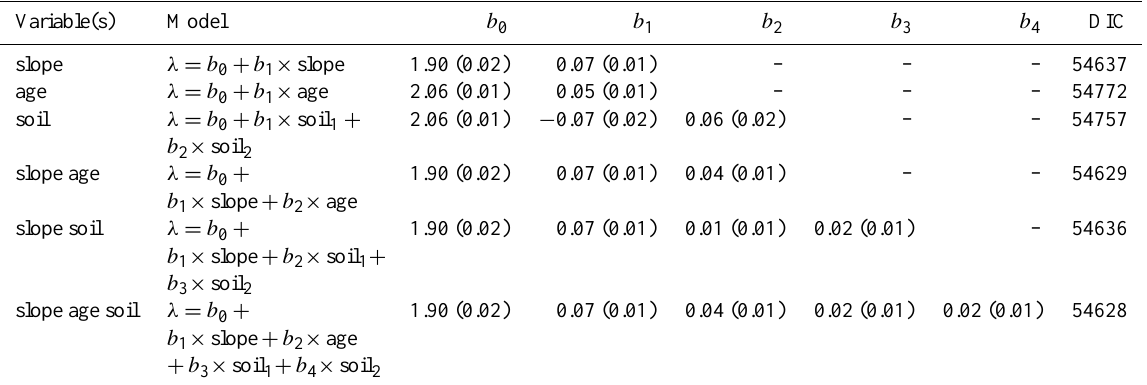
Fig. 3. Differences in the frequency distribution of canopy height between (a) the primary and old-growth forest, and (b) among the three soil types. Table 3. Hierarchical Bayesian model for the effect of slope, forest age and soil type on the gap size distribution ( λ) showing means (and standard errors) of each parameter calculated using MCMC and the model deviance information criterion (DIC). For categorical variables the following values were used: old-growth forest = − 1, old secondary forest = 1; brown fine loam = ( − 1, − 1), pale swelling clay = (1,0), red light clay =